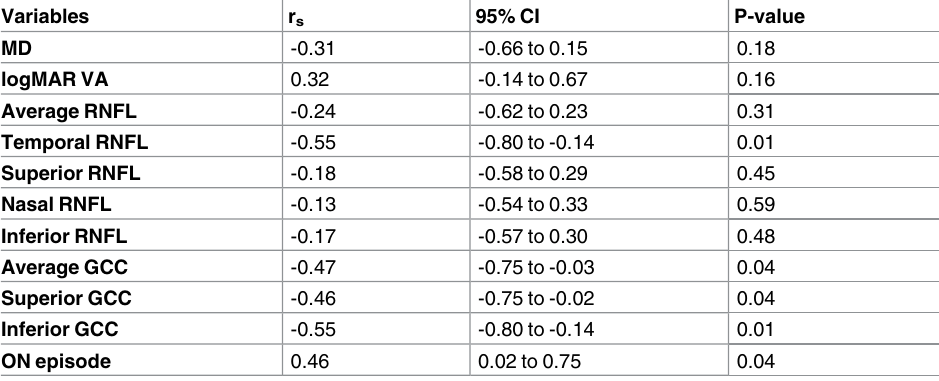
Table 4. Retinal Structure Correlations with Ab Titer in the AQP4 Ab-Positive Group.